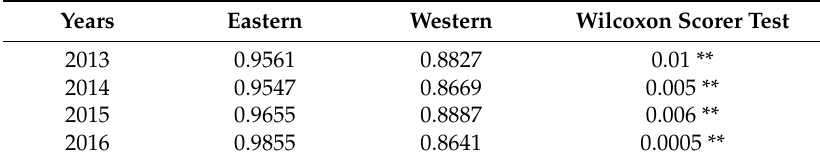
Table 5. Wilcoxon signed rank Test of technology gap.